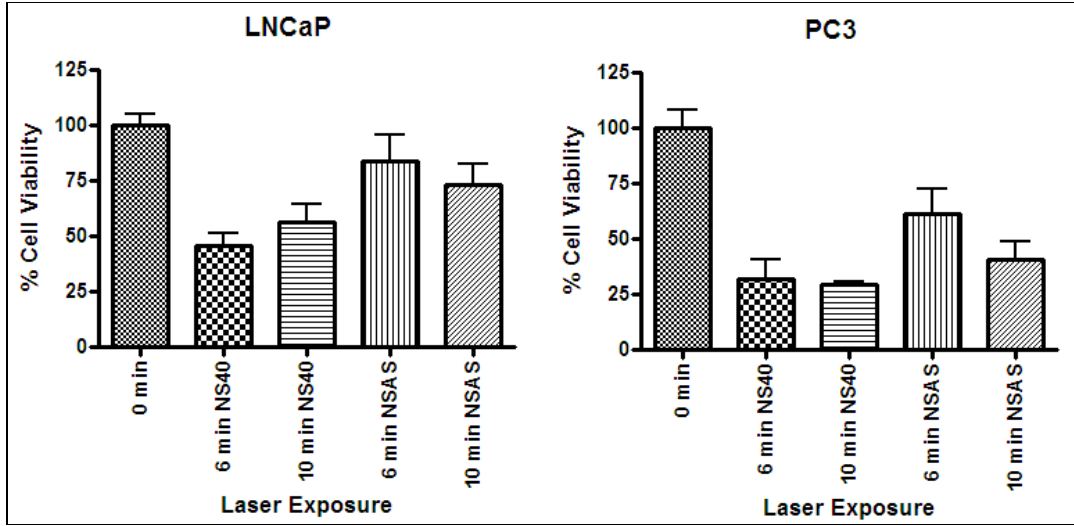
Figure 11. Representative photothermal experiment on LNCaP ( left ) and PC3 ( right ) incubated with 40 nm gold nanoshells (NS40) and Auroshell® particles (NSAS). Irradiated with a 4 W laser with a 42 ° C background temperature.